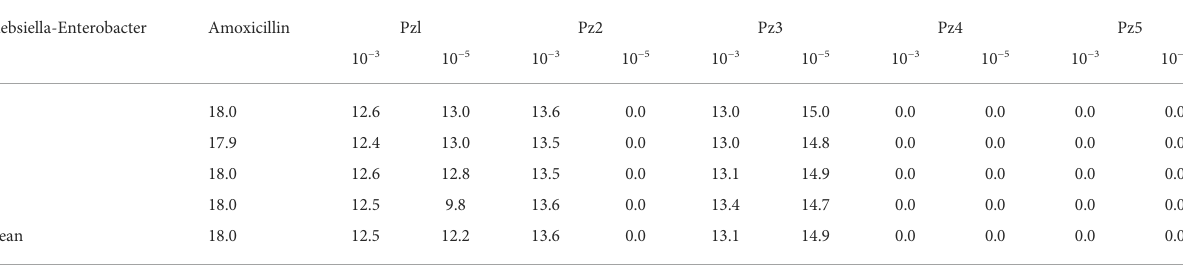
TABLE3Inhibition zones(presentedinmillimeters)ofPz1,Pz2,Pz3,Pz4,Pz5, andamoxicillinshown onATCCstrainsof Klebsiella – Enterobacter spp.